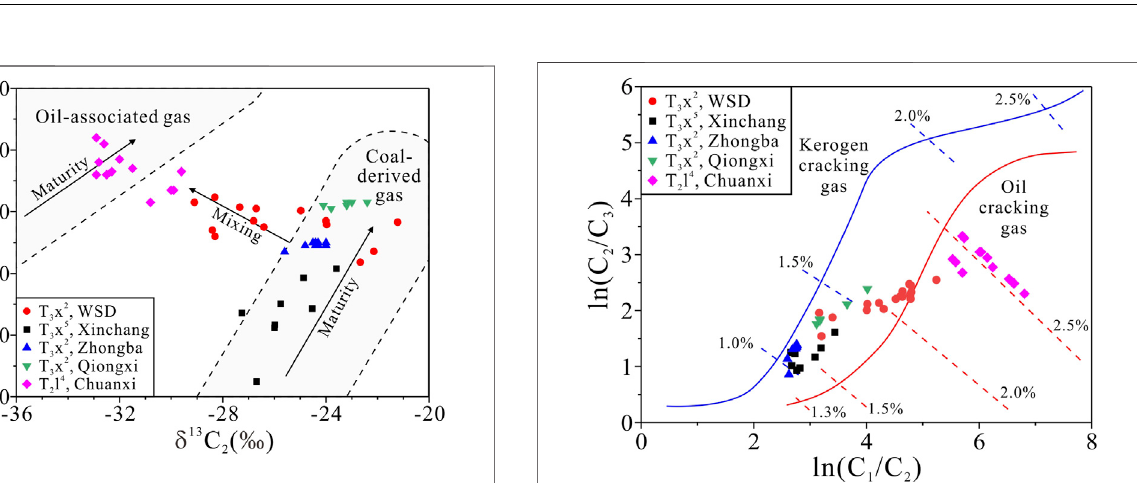
FIGURE 7 | The cross-plot of ln (C 2 /C 3 ) versus ln (C 1 /C 2 ) of the T 3 x 2 gas from the Western Sichuan Depression (modi fi ed after Li et al., 2017).